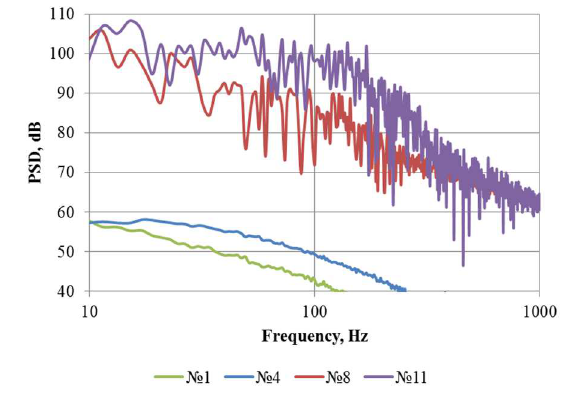
Fig. 13. PSD of the wall-pressure based on the DES model.